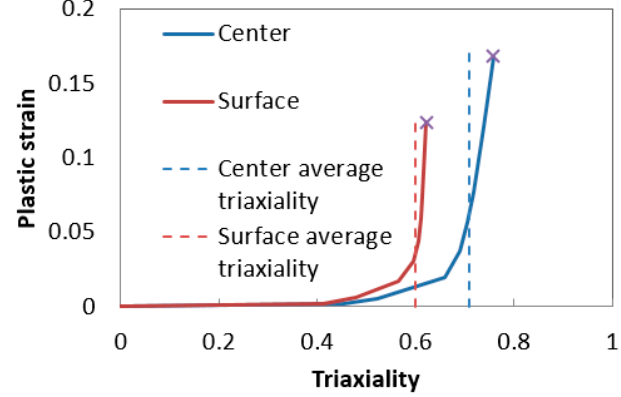
Figure 26. Triaxiality paths for the plane strain test at two points.